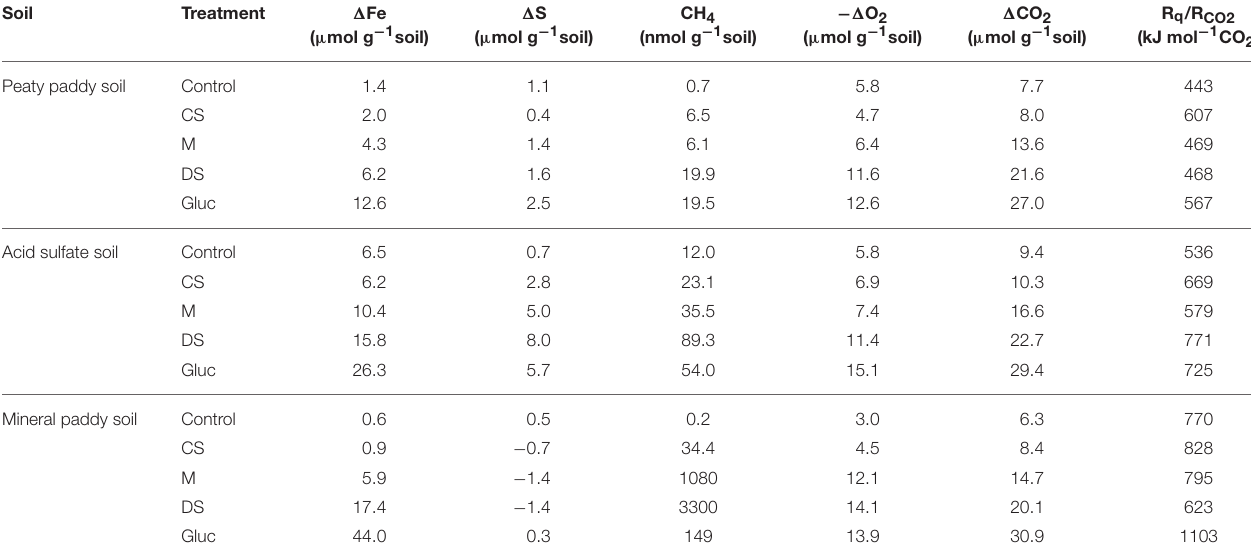
TABLE 3 | Net change in dissolved Fe and S concentrations, total methane production, total O 2 -consumption, and calorespirometric ratios for the 5 days of incubation. Soil Treatment